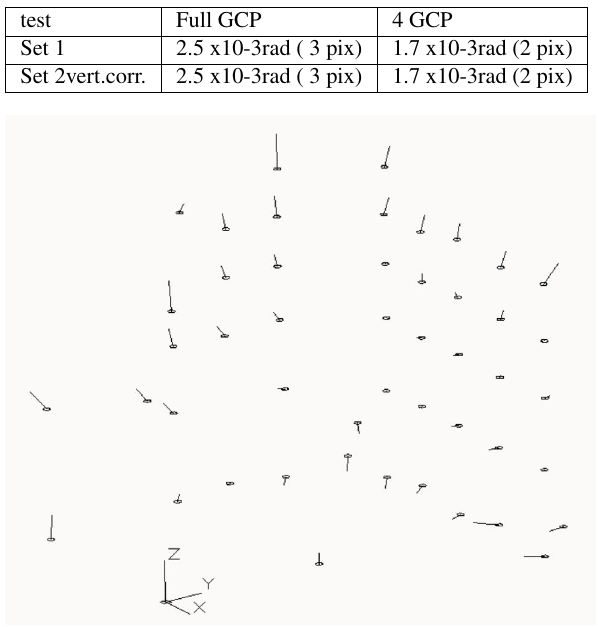
Table 1. Results of the test field